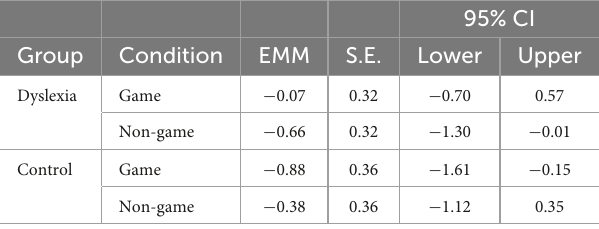
amplitude of the MMN component. This suggests that attention effects do not explain the interaction. Therefore, we argue that the interaction is due to activation of brain representations that has been differently influenced by the training type in the two groups. The difference between the current game and the non-game lies in feedback, freedom of choice, and rich visual features in the former, as opposed none of them in the latter. All these features may